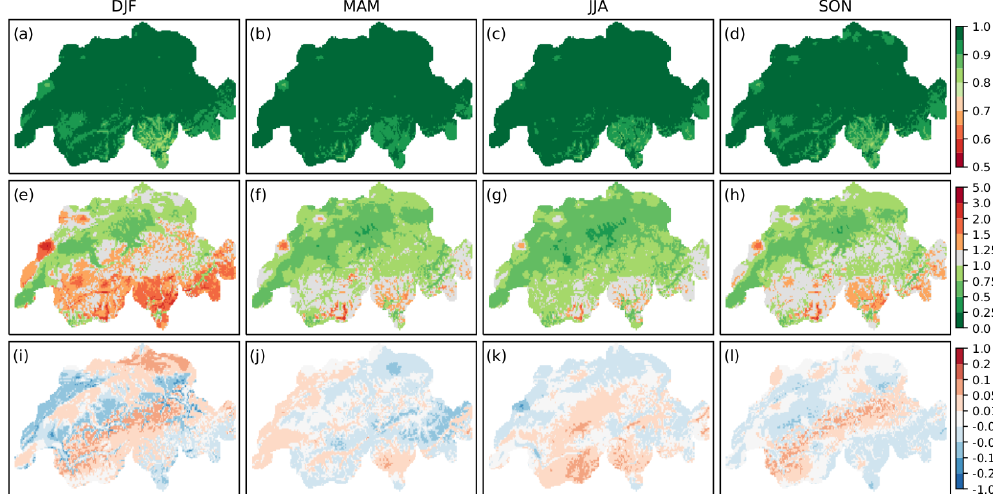
Figure 5. Results of validation over time of EnKF temperature reconstructions for each season. Shown are the Pearson correlation (a–d) , RMSE ( ◦ C) (e–h) , and bias ( ◦ C) (i–l)